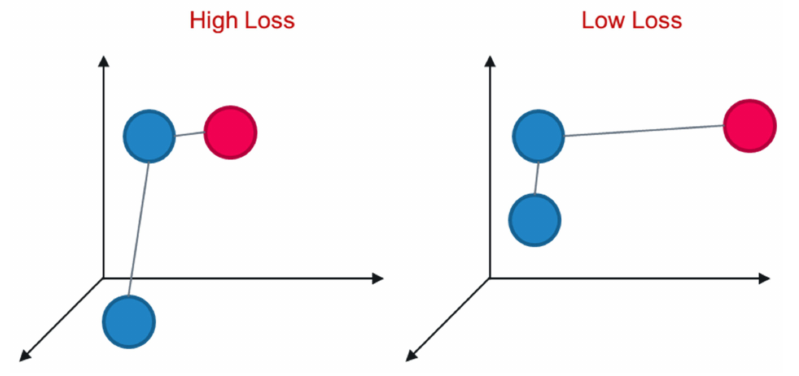
Figure 8. Applied contrastive loss concept.